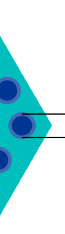
Figure 1. Scheme of cross-section of solid-core photonic crystal fibers (PCF).